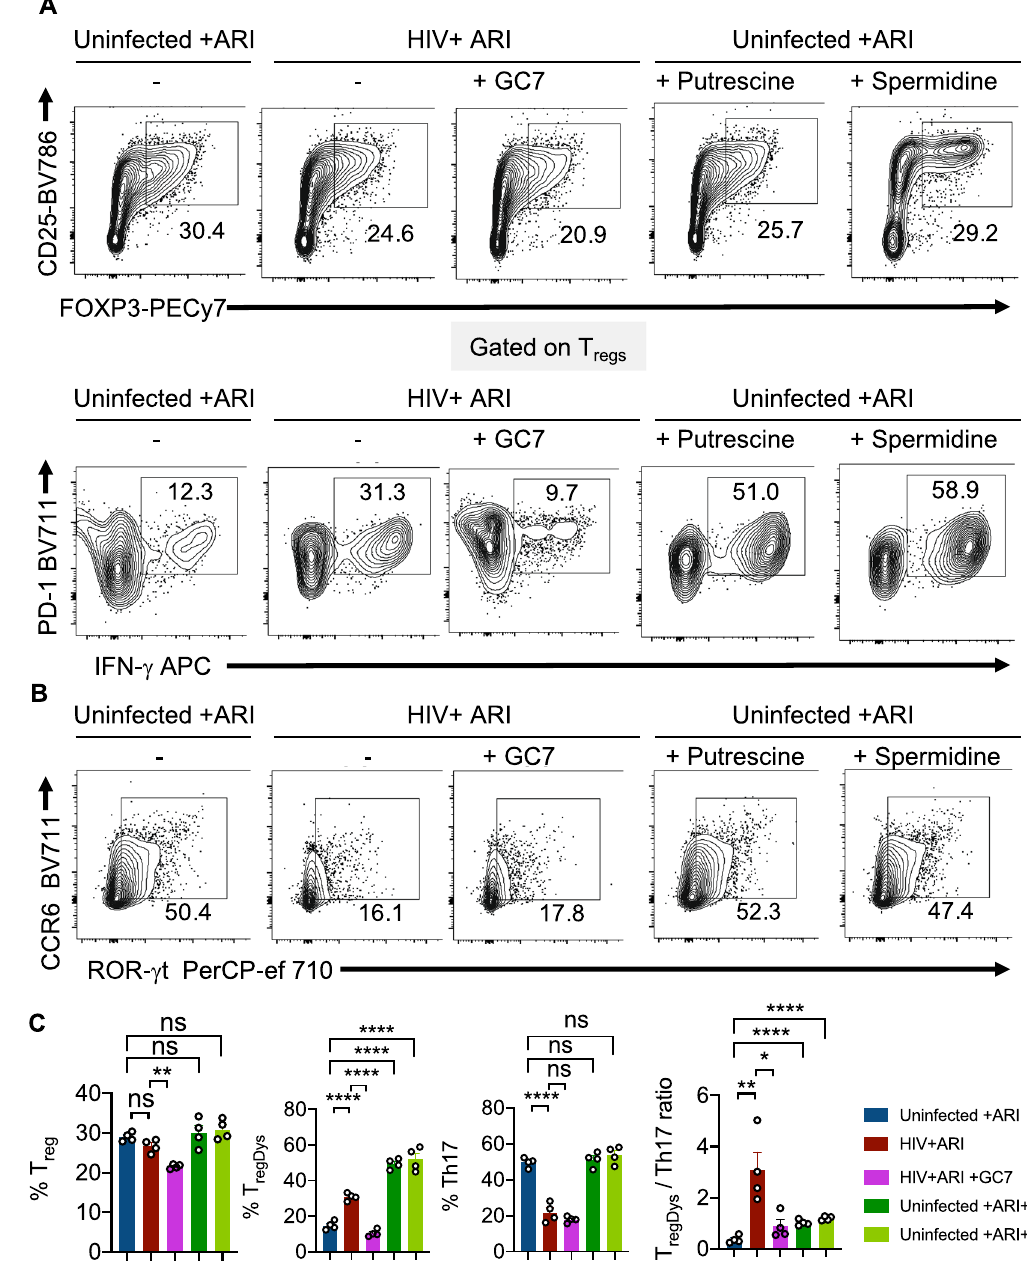
Fig. 7 | HIV-induced skewing of T regDys /Th17 ratios requires polyamine synth- esis. HTOC CD4 + T cells were stimulated as described in the methods. Some cul- tures were HIV-infected with or without GC7 (10 μ M). Other uninfected cultures were treated with Putrescine dihydrochloride (100 μ M) or Spermidine (1mM). A Contour plots showing the percentage of T regs (above) and PD-1 hi IFN- γ + cells in FOXP3 + population (T regDys ) (below). B Contour plots showing ROR- γ t and CCR6